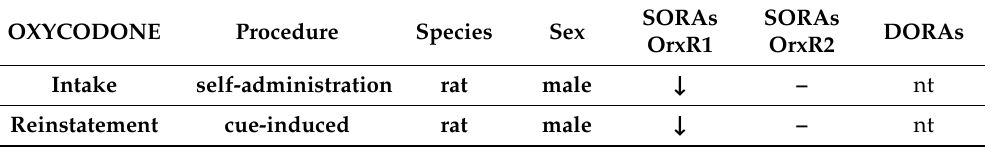
SORAs SORAs DORAs OrxR1 OrxR2